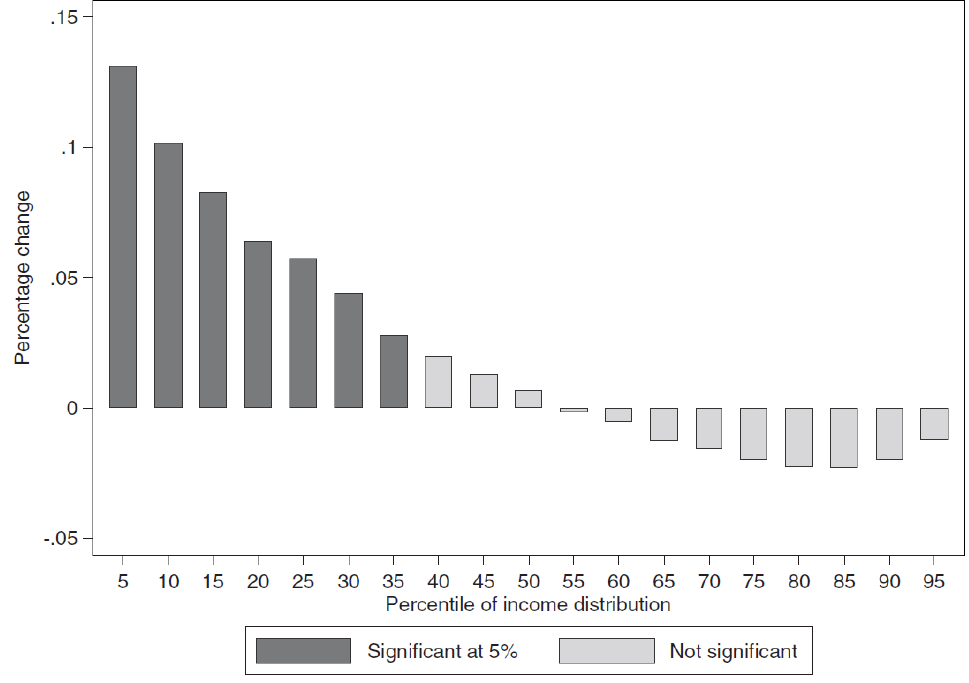
Figure 4. Effects of deregulation on percentiles of the income distribution. Source: Reproduced with permission from Beck et al. (2010, p.